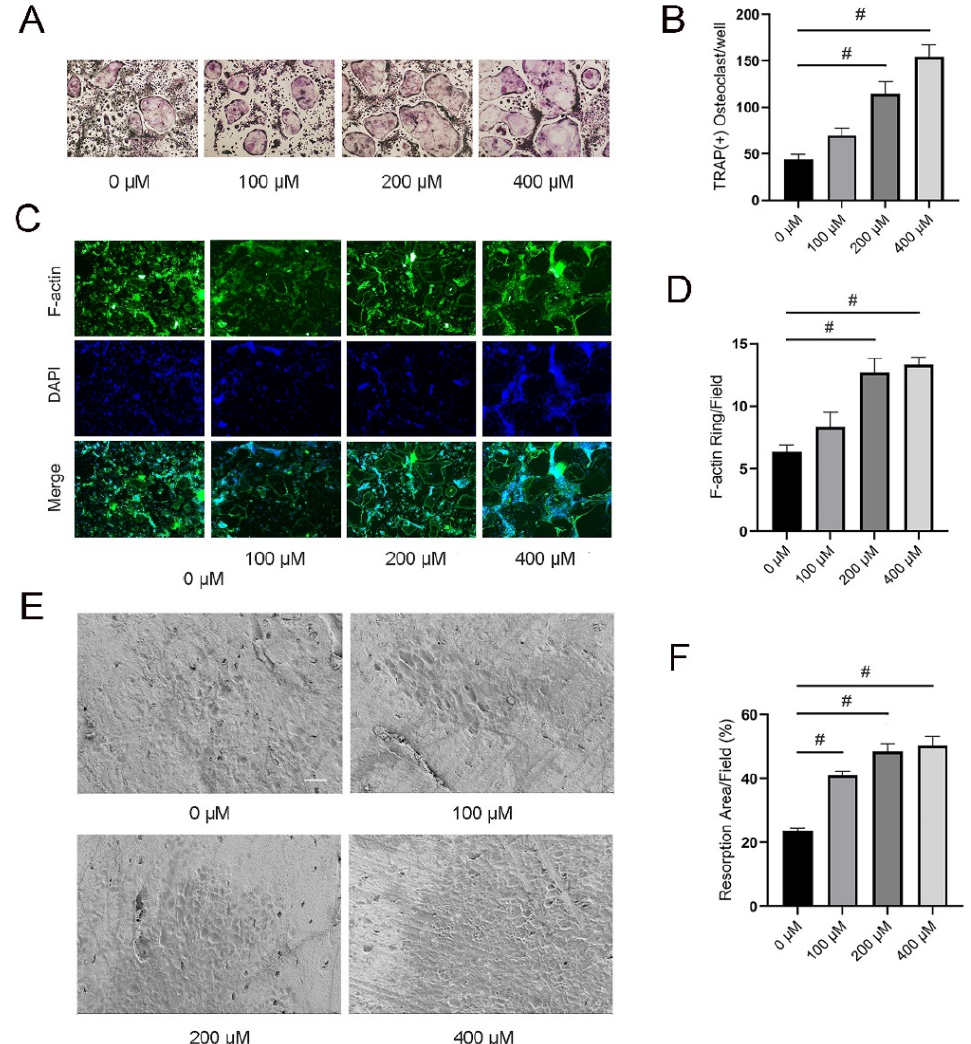
Figure 2. TMAO promoted osteoclast differentiation and resorption. ( A , B ) TMAO promoted TRAP- positive osteoclast formation in a dose-dependent manner. Scale bar = 20 µ m. BMMs were cultured in α -MEM containing 30 ng/mL M-CSF and 100 ng/mL RANKL under different concentrations of TMAO for 4 days. Osteoclasts were stained by a TRAP staining kit. TRAP-positive osteoclasts were observed and counted by open-field microscopy. ( C , D ) TMAO increased F-actin ring formation in a dose-dependent manner. Scale bar = 200 µ m. BMMs were cultured in α -MEM containing 30 ng/mL M-CSF and 100 ng/mL RANKL under different concentrations of TMAO for 4 days. The cells were stained with rhodamine-conjugated phalloidin for 60 min and then stained with 4 (cid:48) ,6-diamidino- 2-phenylindole for 5 min. Then the F-actin rings were observed by a fluorescence microscope. ( E , F ) TMAO increased bone resorption area in a dose-dependent manner. Scale bar = 50 µ m. BMMs were seeded on the sterilized bovine bone slices and treated with different concentrations of TMAO for two weeks. The bone resorption area was observed under a scanning electron microscope. # p < 0.01.